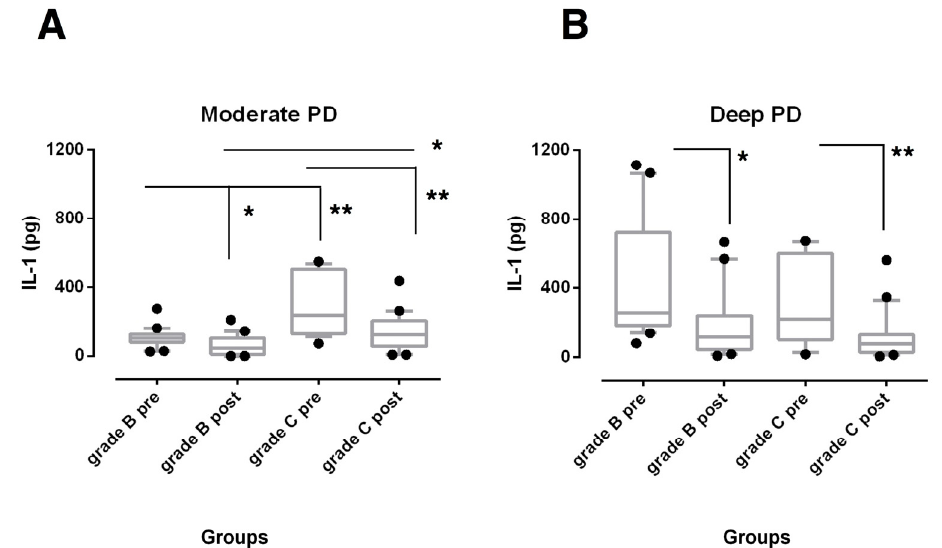
Figure 1. Box-and-whisker plots showing the total amount of interleukin (IL)-1 β in gingival crevicular fluid of moderate ( A ) and deep pocket sites ( B ) in subjects with grade B and grade C stage III periodontitis before (pre) and after non-surgical periodontal therapy (post). Horizontal line represents the median with the box representing the 25th and 75th percentiles, and the whiskers denote the 5th and 95th percentiles. * p < 0.05, ** p < 0.01.